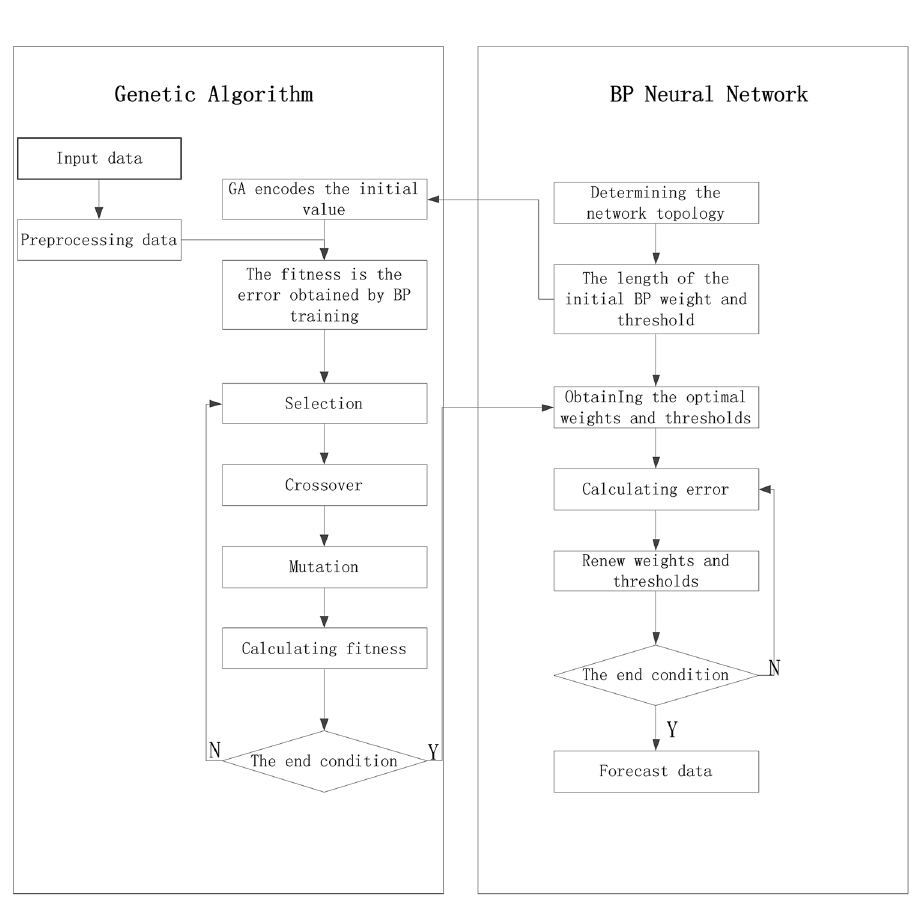
Figure 12. Topological structure of GA-BP neural